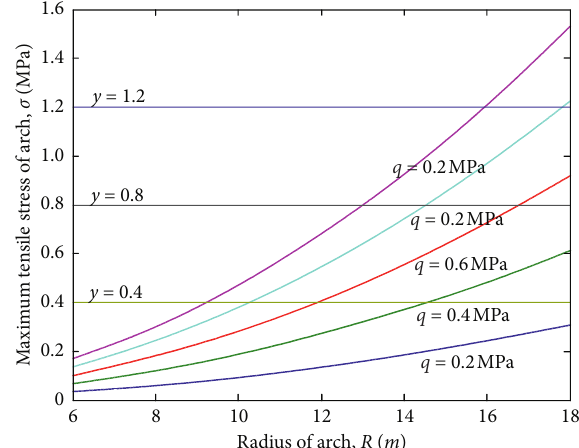
Figure 10: Relationship between arch stress, overburden rock load, and arch radius.